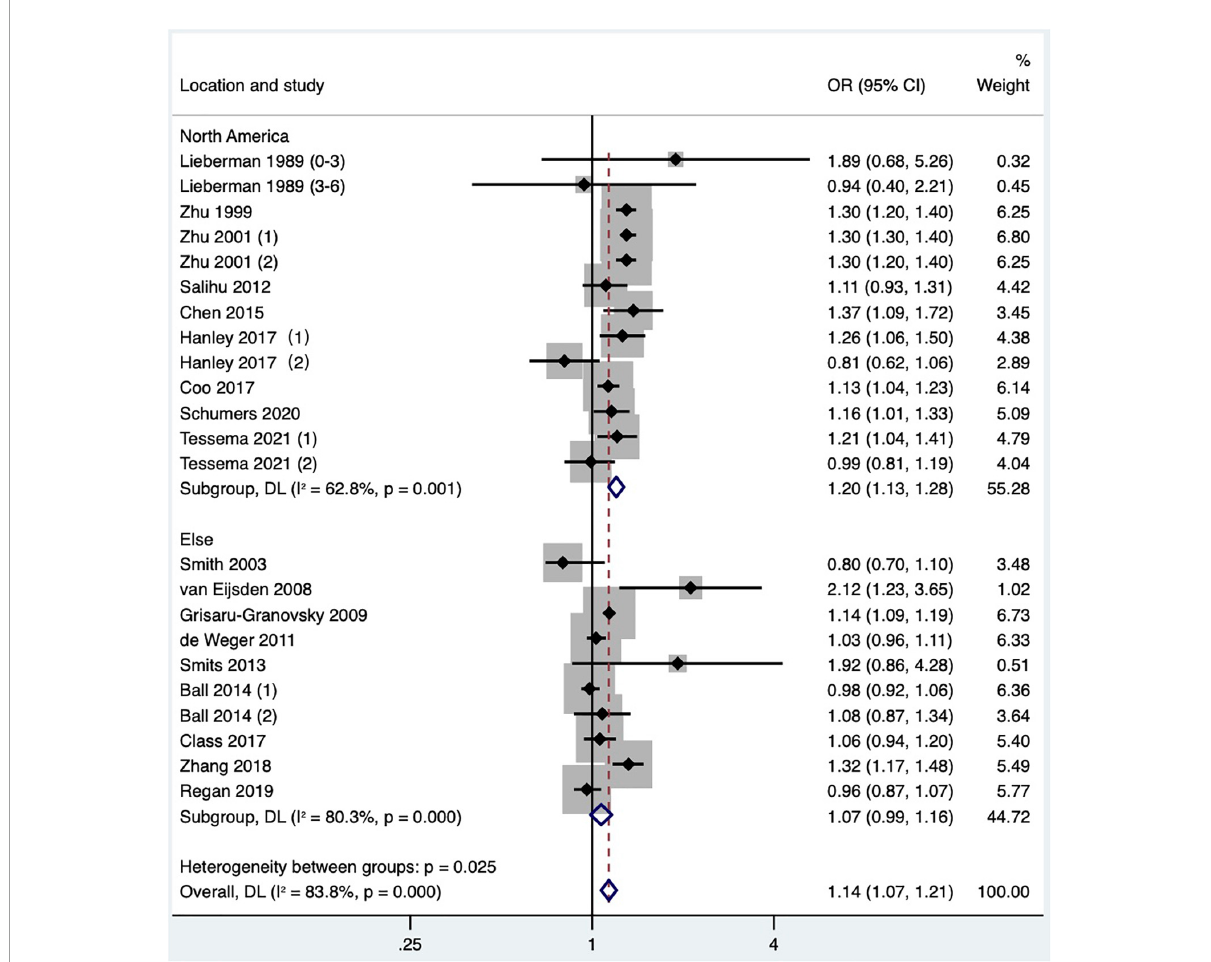
FIGURE10 Subgroup analysis of the effect of short IPI on SGA. Lieberman et al. (13) (0–3) referred to the IPI of 0–3 months vs. 18–23 months; Lieberman et al. (13) (3–6) referred to the IPI of 3–6 months vs. 18–23 months; Zhu et al. (15) (1) was white data, Zhu et al. (15) (2) was black data; Hanley et al. (36) (1) was non-matching data, and Hanley et al. (36) (2) was within-mother matching data; Ball et al. (24) (1) was non-matching data, and Ball et al. (24) (2) was within-mother matching data; Tessema et al. (48) (1) was non-matching data, and Tessema et al. (48) (2) was within-mother matching